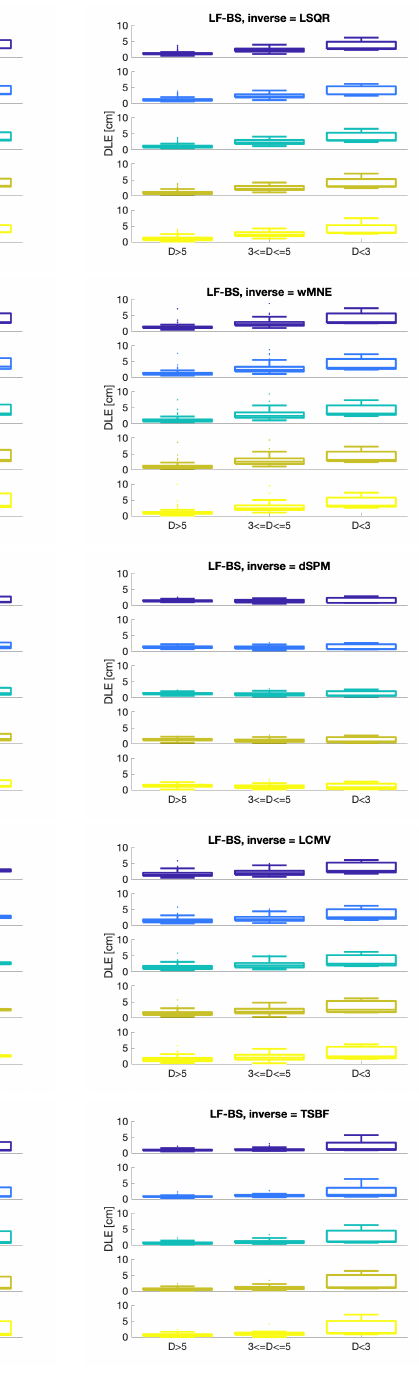
Figure 1. Synthetic sources: boxplots of distance localization error (DLE) with respect to the distance D [cm] of the true source from the origin for lead-field matrix computed using the boundary element method (LF-BEM) (first column), lead-field matrix computed using the spherical model (LF-SP) (second column), and lead-field matrix computed using the discretized Biot–Savart law (LF-BS) (third column) and different values of M . Color legend: Blue: M = 500; Light blue: M = 1000; Sea green: M = 2000; Ochre: M = 4000; Yellow: full source space. Least squares method (LSQR), the weighted minimum norm estimates (wMNE), the dynamic statistical parametric map (dSPM), and linearly constrained minimum variance (LCMV) truncated singular value decomposition beamforming